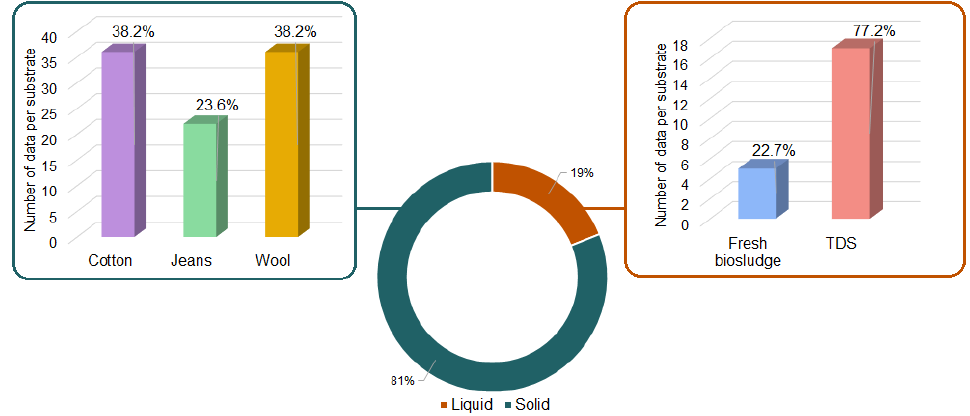
Figure 1. Different sources of textile waste used in AD reported in the literature included in the meta-analysis. TDS = textile dyeing sludge. Table 1. Chemical characterization of different textile sources presented as averages 1